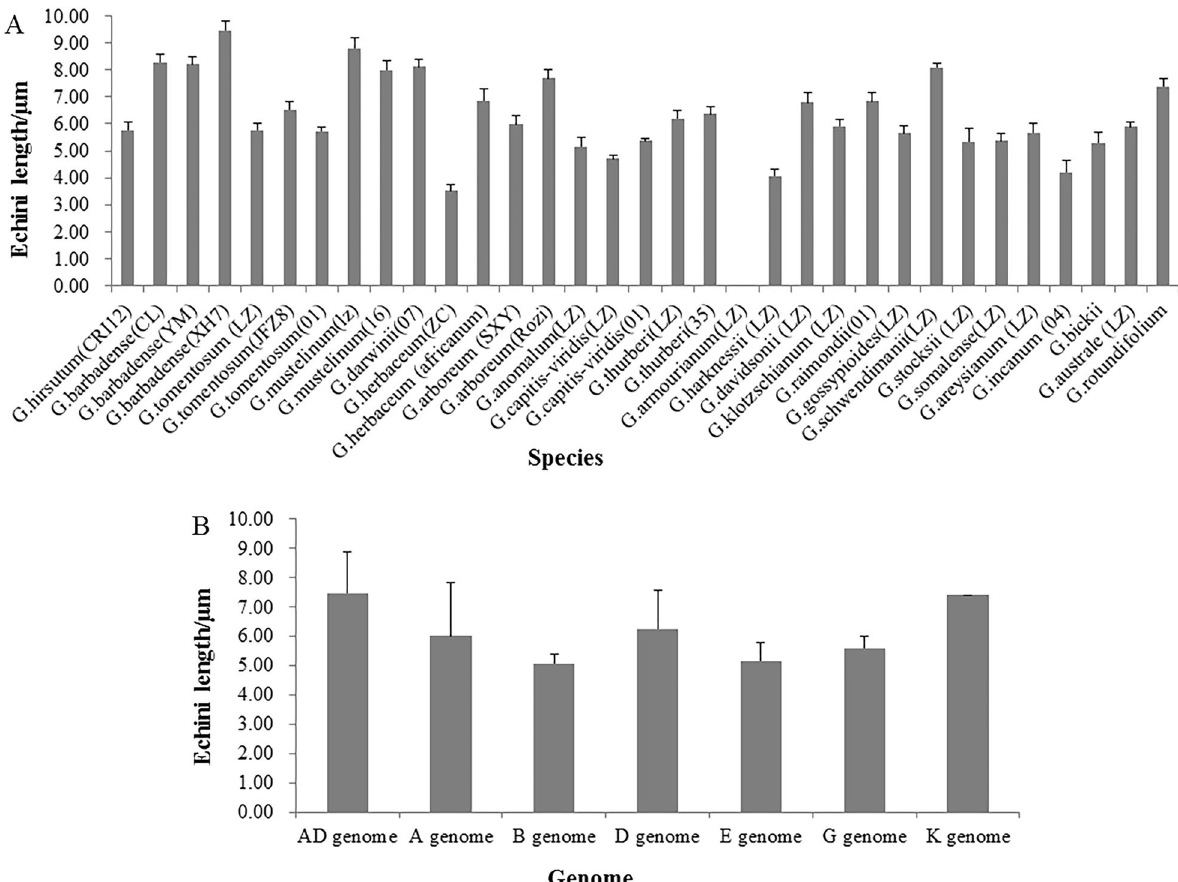
Fig. 3 The length of exine spine in the Gossypium species. A Comparison of exine spine length among Gossypium species. B Comparison of exine spine length among different genomes of Gossypium